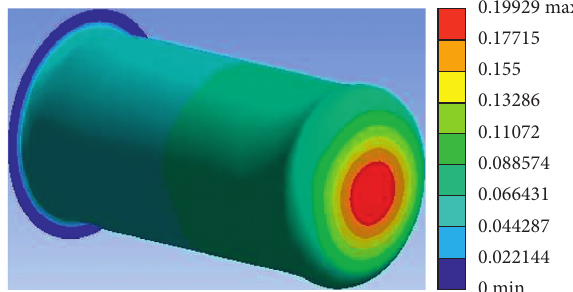
Figure 21: Total deformation cloud of the flame tube without coupling.